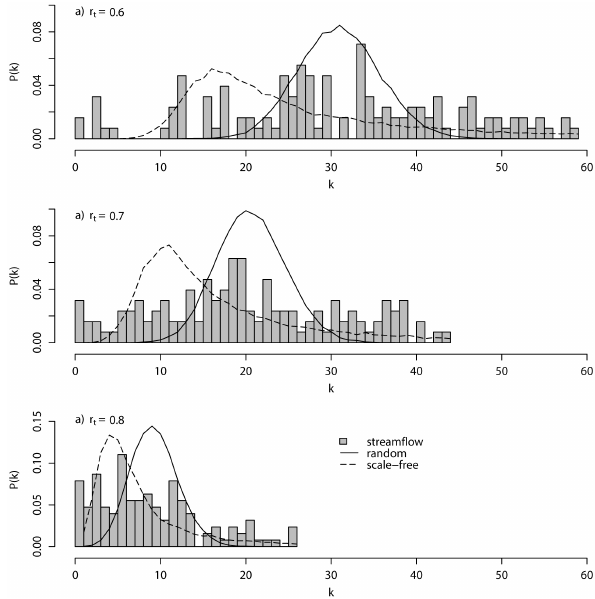
Figure 5. Degree distribution, P(k) , for three values of the correla- tion coefficient threshold, r t , for the streamflow network (grey bars). Also shown are the ensemble means of the expected degree distri- butions for a random network (solid line) and a scale-free network with P(k) ∝ k − 2 for large k (dashed line). The random and scale- free networks were configured to have the same number of vertices and edges as the streamflow network.